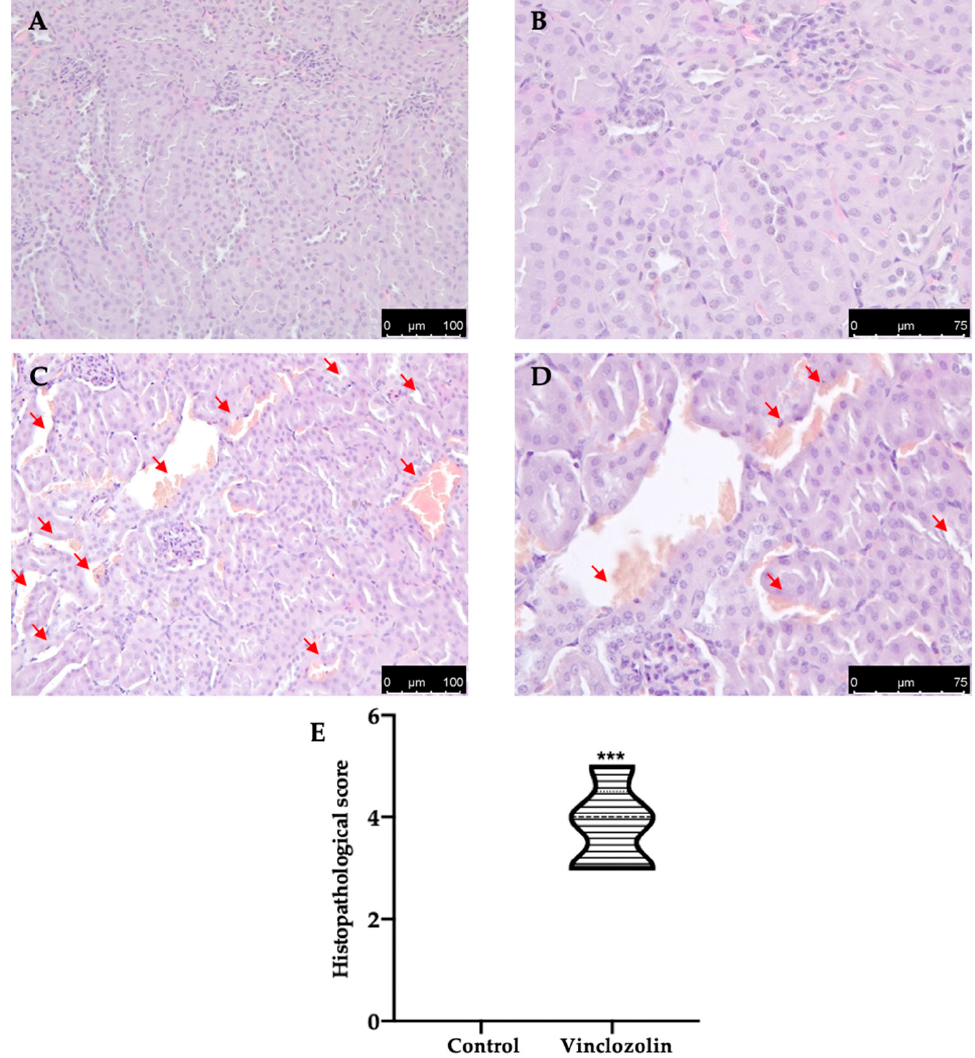
Figure 2. Effects of vinclozolin exposure on kidney histology: H&E staining: ( A ) control magnification 20×; ( B ) control magnification 40×; ( C ) vinclozolin magnification 20×; ( D ) vinclozolin magnification 40×; ( E ) histopathological score. Red arrow: tubular dilatation and necrosis. A p -value less than 0.05 was considered significant. *** p < 0.001 vs. control.